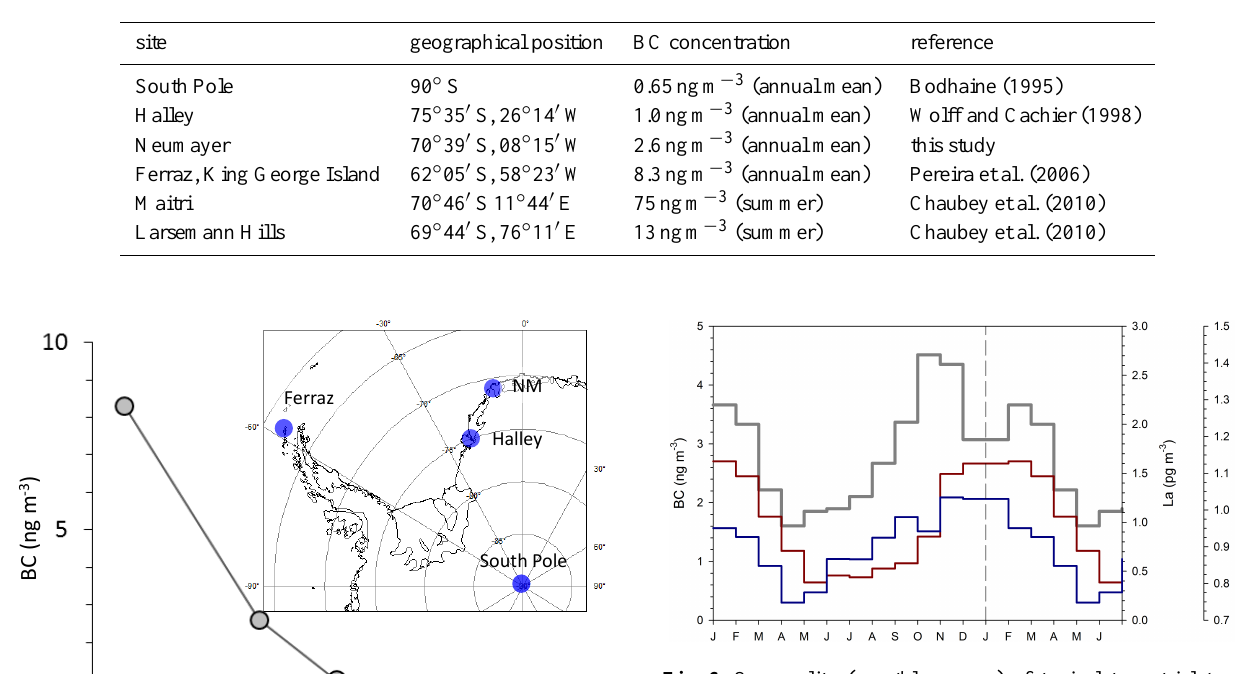
Table 1. BC concentration measured at different Antarctic sites.